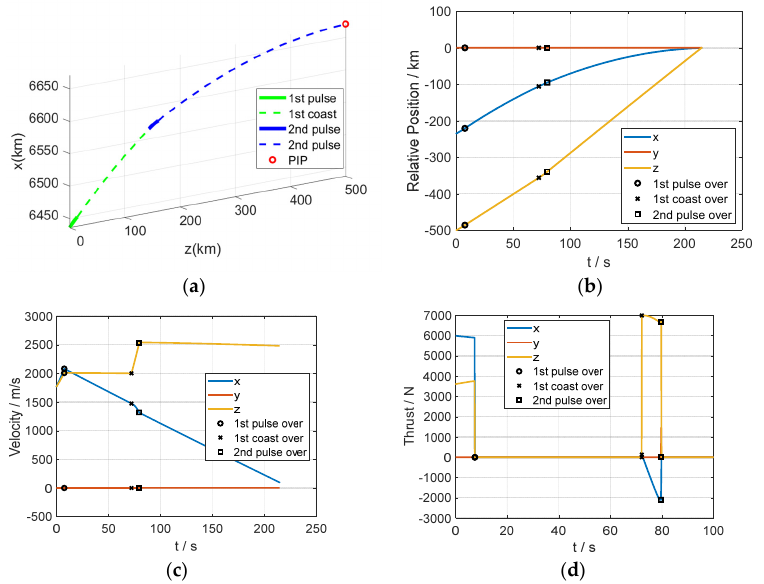
Figure 3. Curves of the state and control variables of the interceptor in scenario 1: ( a ) trajectory, ( b ) relative position, ( c ) velocity, and ( d ) thrust. Table 2. Results of the proposed method in scenarios 1 and 2.